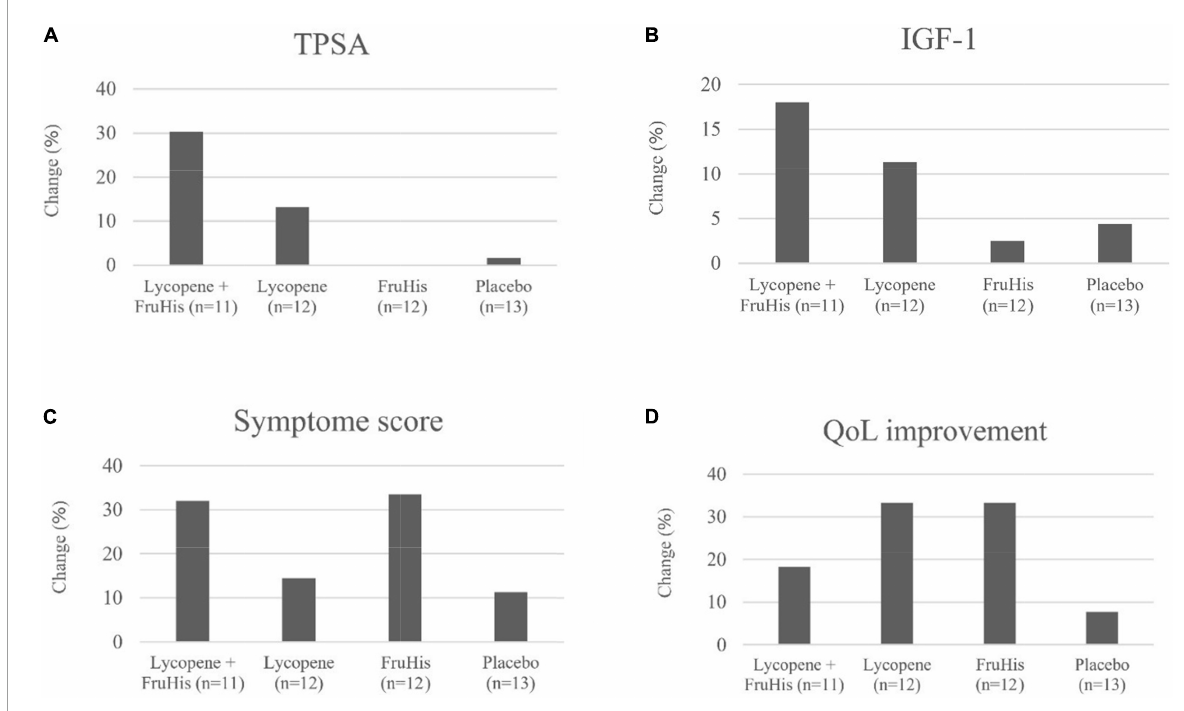
FIGURE2 The effects of lycopene and FruHis supplementation, combined and alone, on TPSA (A) , IGF-1 (B) , symptom score (C) , and QoL improvement (D) among patients with BPH. QoL improvement was considered as changing the scores of 4–6 to 0–3 (based on QoL question in IPSS) throughout the trial. IPSS, international prostate symptom score; QoL, quality of life; TPSA, total prostate-specific antigen; IGF, insulin-like growth factor; BPH, benign prostatic